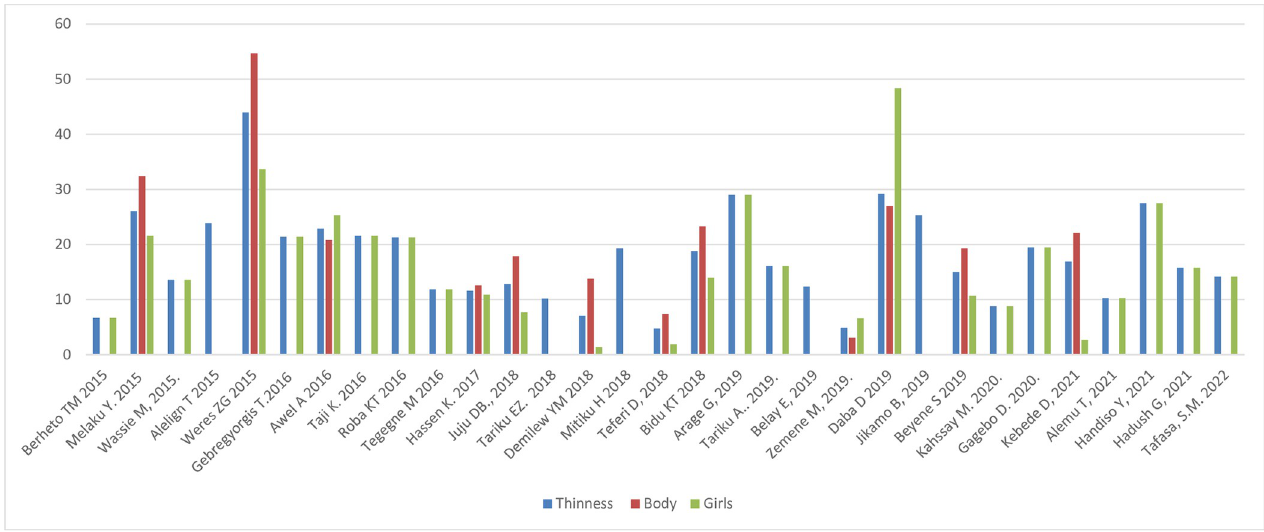
Fig 7. Trends in adolescent thinness by sex in Ethiopia over the last 6 years.